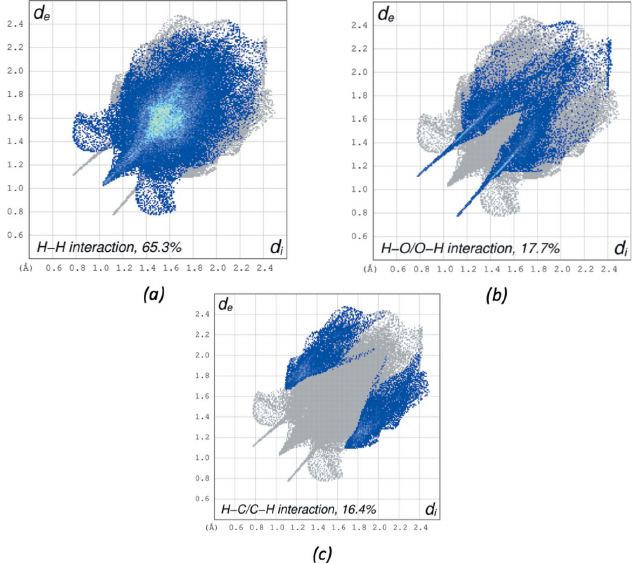
Figure 8 The two-dimensional fingerprint plots for I delineated into ( a ) H (cid:5)(cid:5)(cid:5) H contacts, ( b ) H (cid:5)(cid:5)(cid:5) O/O (cid:5)(cid:5)(cid:5) H contacts, ( c ) H (cid:5)(cid:5)(cid:5) C/C (cid:5)(cid:5)(cid:5) H contacts. Other contact contributions less than 1% are